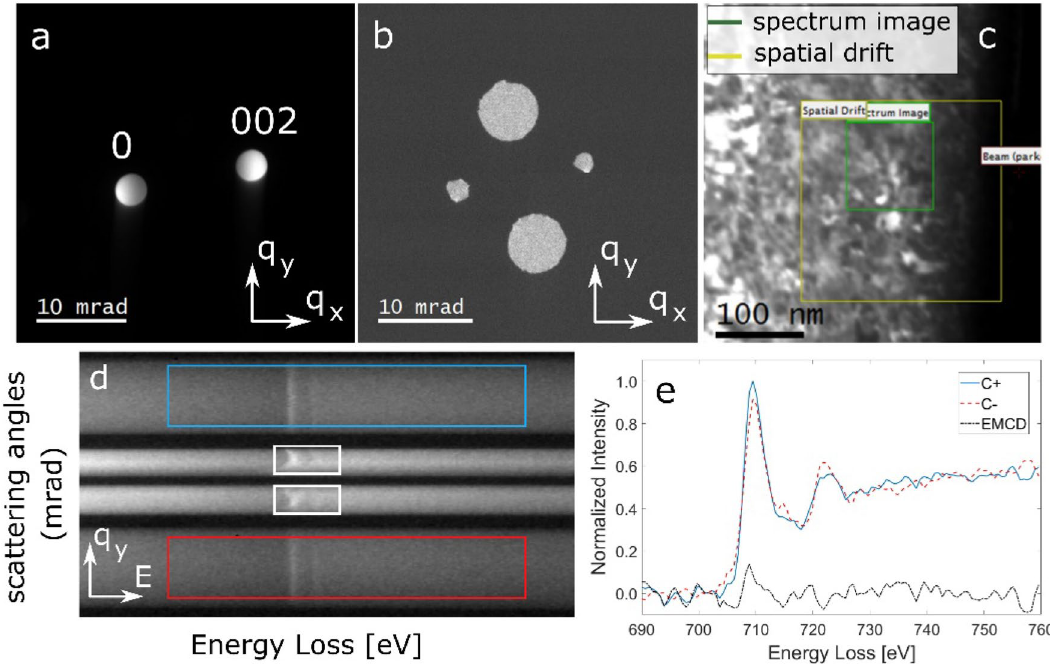
Figure 8. (a) Experimentally obtained 2-beam diffraction condition for EMCD experiments with g = (002) as diffracted beam. (b) An image of the quadruple aperture. (c) ADF survey image used to acquire the EMCD- orientation maps with green box showing the measurements area. (d) 2D EELS image extracted from one scan point of the acquired 4D data cube. The C + and C- EELS spectra for the EMCD measurements were extracted from the upper and lower traces respectively by integrating the intensities in the marked regions whereas the intensities of g and 0 beams were determined by summing up the intensities in the white rectangles marked in the second and third traces respectively. (e) The background subtracted and post edge normalized EELS spectra extracted from d together with their difference (EMCD)